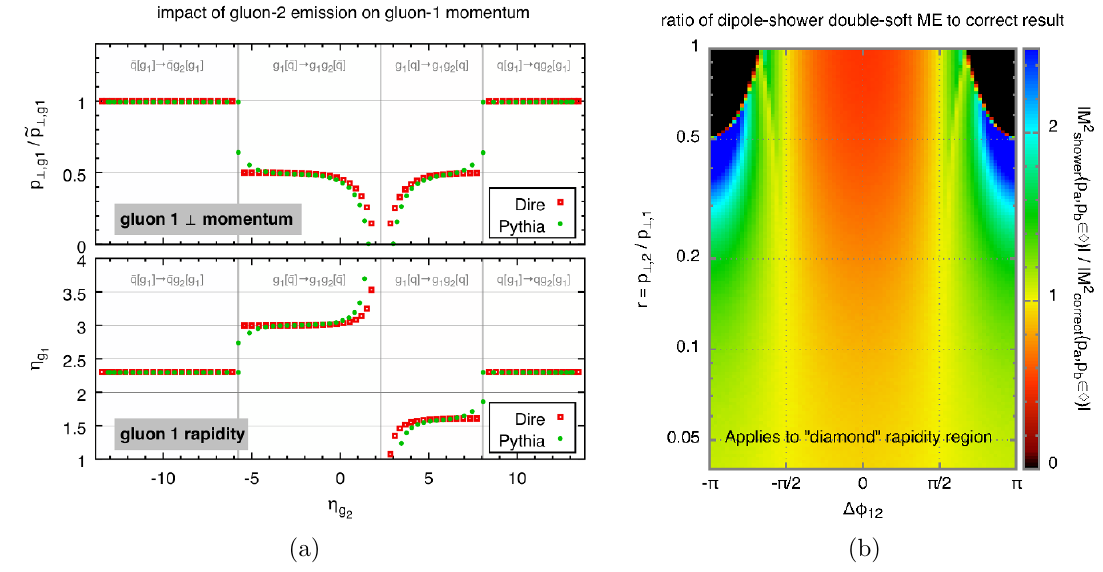
Figure 3. (a) Illustration of the modi(cid:12)cation of the transverse momentum (upper panel) and rapidity (lower panel) of gluon 1 after emission of gluon 2, shown as a function of the rapidity of gluon 2. Prior to emission of gluon 2, gluon 1 originally has a rapidity (cid:17) g momentum p ? ;g = v 1 = 10 (cid:0) 6 Q ( v 1 = 10 (cid:0) 6 Q and 1 (cid:0) z 1 = 10 (cid:0) 5 ). Gluon 2 has v 2 = 1 e 1 is emitted parallel in azimuth to gluon 1. To help guide the eye, four regions of gluon 2 rapidity are labelled according to the identity of the parton that branches and that of the spectator. The results have been obtained using a numerical implementation of the kinematic maps of section